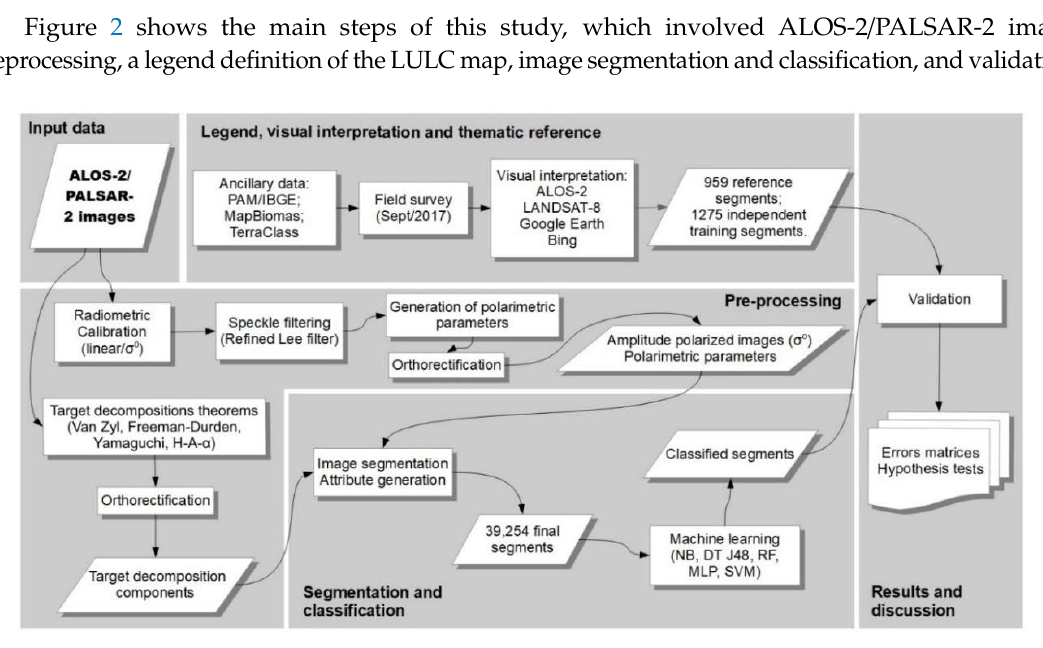
Figure 2. Flow chart of the main steps of the study. NB = Naive Bayes; DT = Decision Tree; RF = Random Forest; MLP = Multilayer Perceptron; SVM = Support Vector Machine; PAM = Produção Agrícola Municipal.